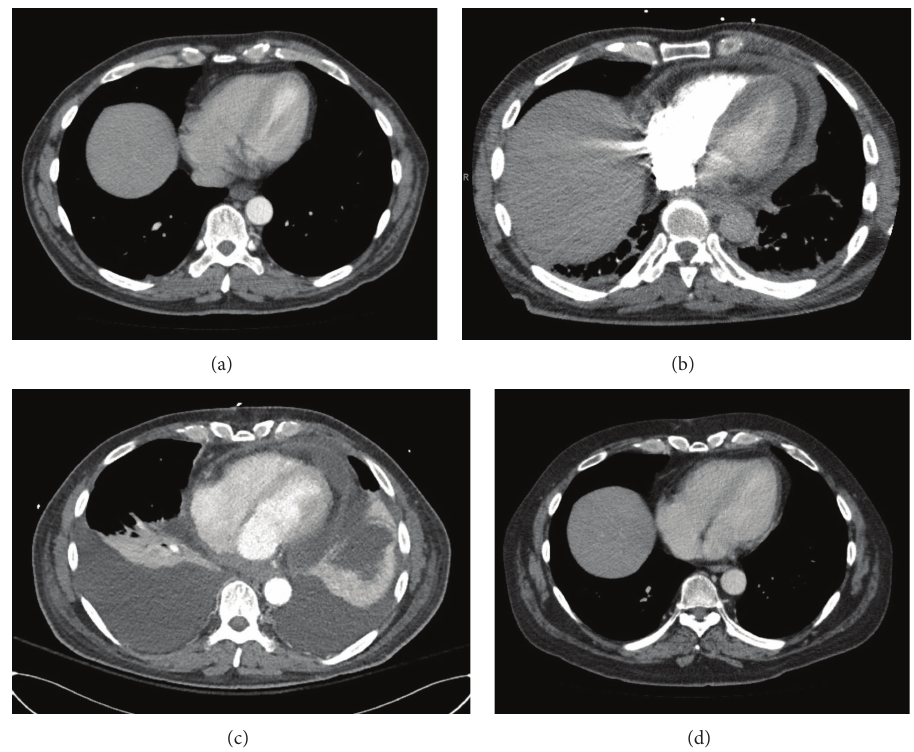
Figure 1: CT chest on admission showed pericardial thickening, moderate-sized pericardial effusion, and adjacent inflammatory changes within the epicardial fat and mediastinum (b), which were new compared to the prior study (a). New large bilateral pleural effusion with associated compressive atelectasis in the lower lungs and stable pericardial effusion is observed on day 10 (c), which resolved after systemic steroid treatment (d).